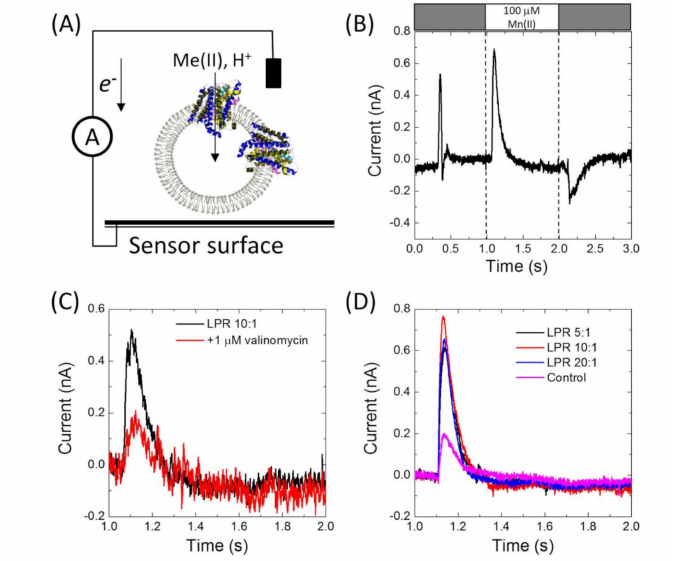
Figure 3. ( A ) Schematic representation of the electrophysiological method based on a solid-supported membrane platform. Proteoliposomes are adsorbed on a gold sensor surface. Transport of charges species into the lumen of the liposomes results in a current in the electric circuit between the solution and the gold surface. ( B ) Example of the electrophysiology experiments of his-tagged MntH2 proteoliposomes (LPR 10:1 ( w / w )) in 10 mM MES / HEPES / CHES bu ff er, pH 8.0, 140 mM KCl and 2